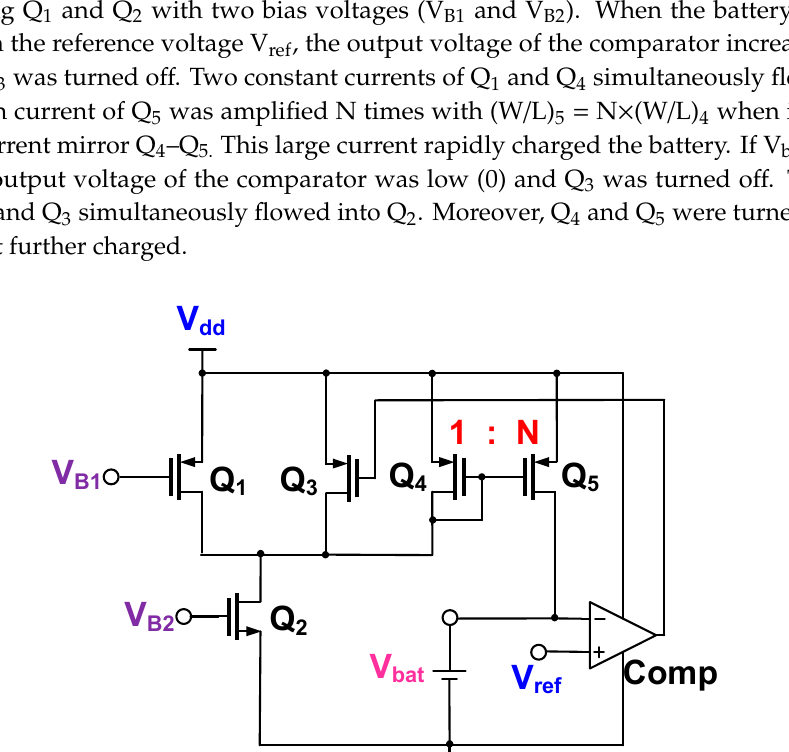
Figure 8. Complete circuit of charge control circuit.